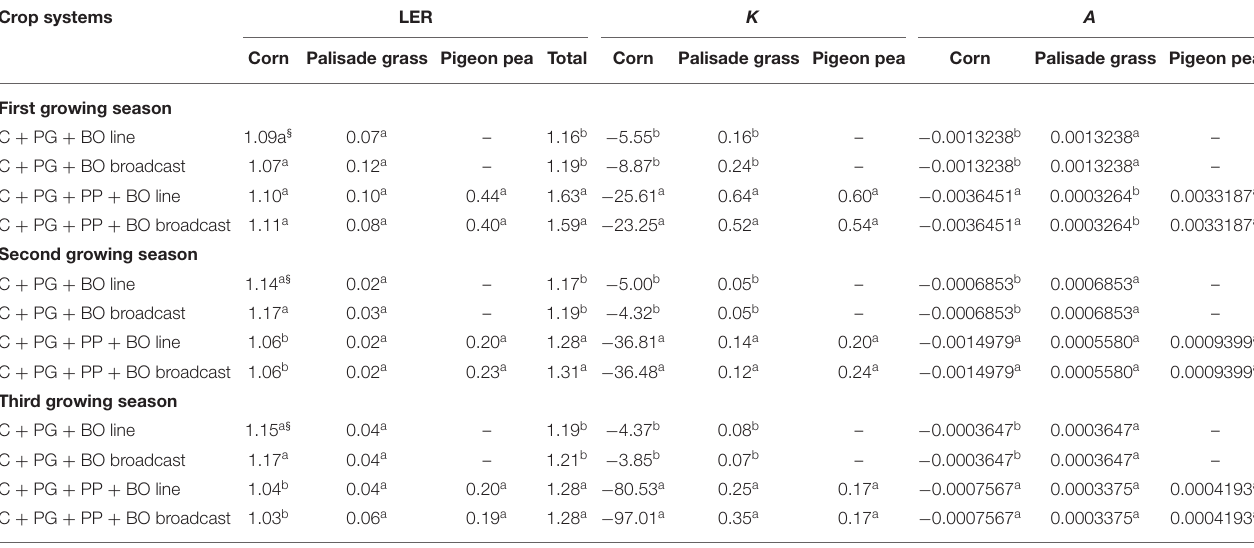
TABLE 7 | Land equivalent ratio (LER) of corn, palisade grass, and pigeon pea monoculture, relative crowding coefficient ( K ) and aggressivity ( A ) of corn to silage intercropped with palisade grass (C + PG) and with palisade grass and pigeon pea (C + PG + PP) with black oat (BO) oversown in lines and broadcast in three growing seasons.